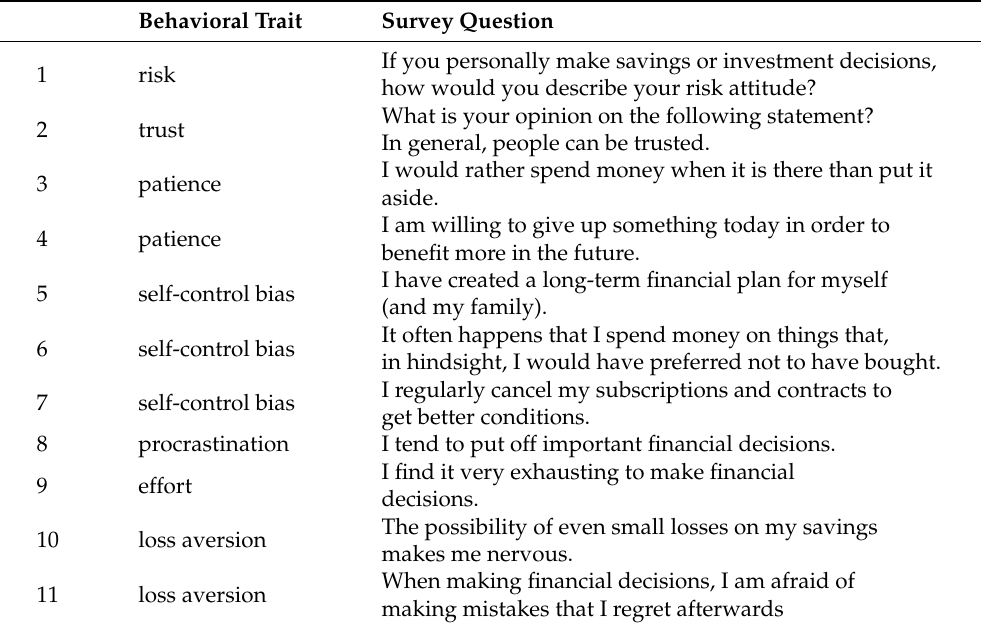
Table 2. Survey questions on behavioral traits. Source: Own